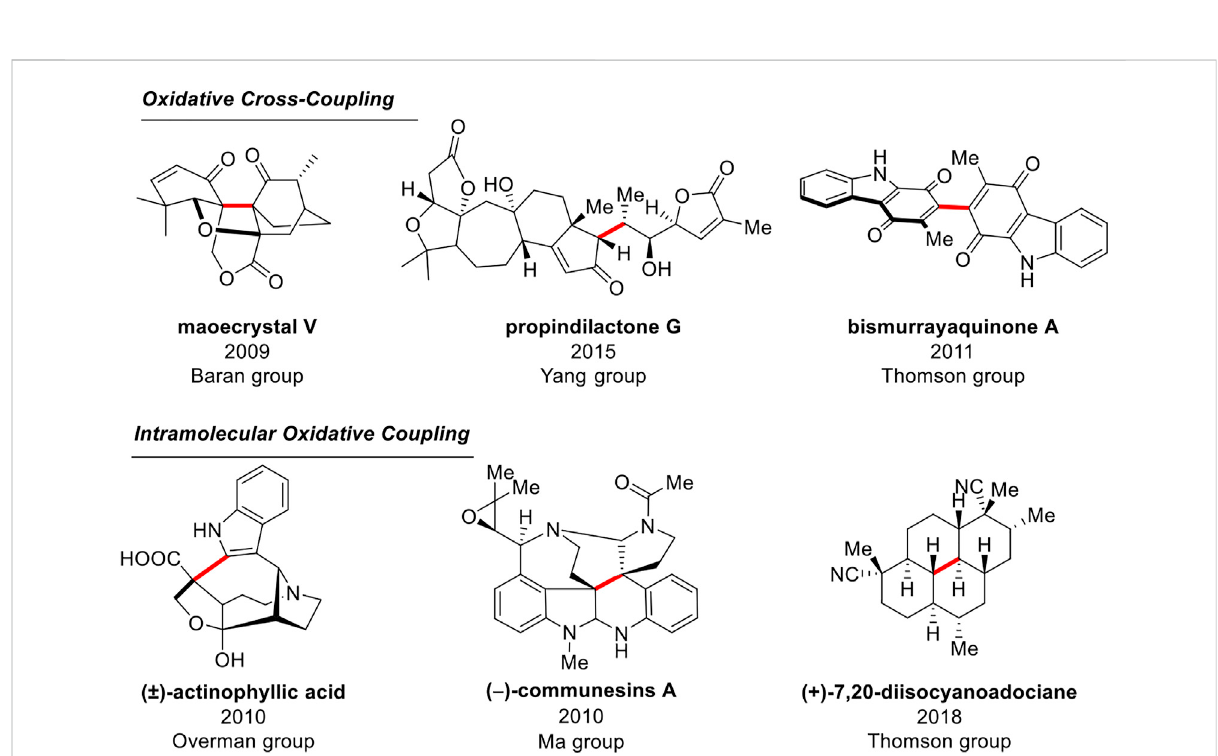
Application of EOC reaction in the synthesis of natural